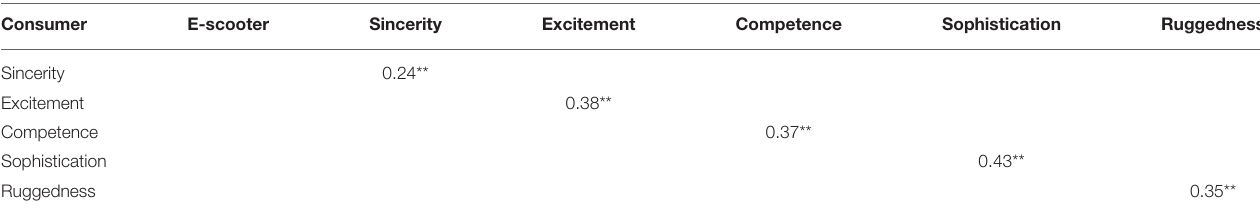
TABLE 4 | Correlations between the corresponding scales of the J. Aaker method “Brand Identity” and modifications for measuring identity.